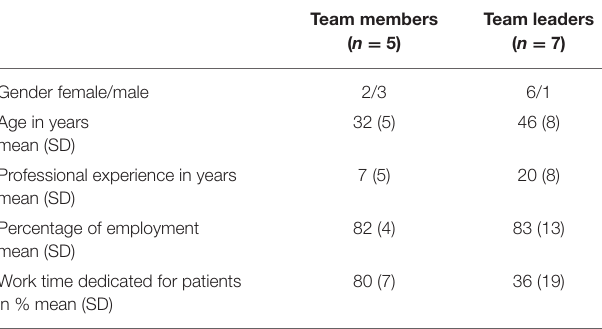
TABLE 5 | Demographic data of focus group